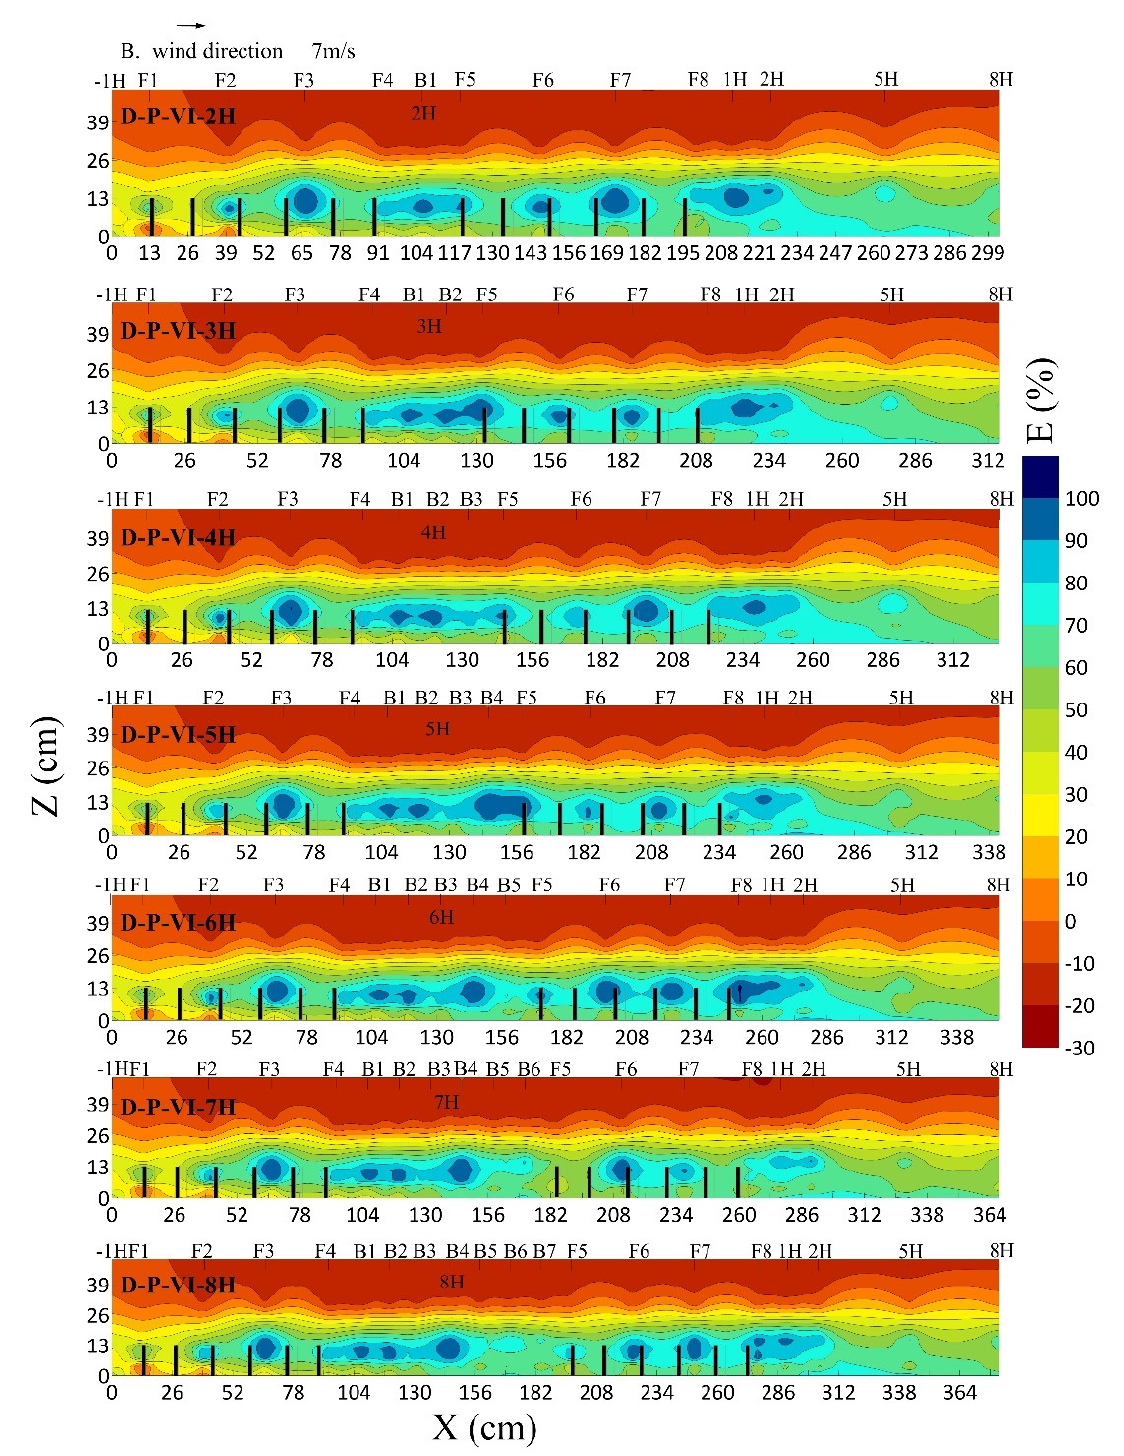
Figure 8. Contour map of the distribution of the shelter efficiency of double pure arbor shelterbelts under different belt spacings. The belt spacing ranges from 2H to 8H. The abscissa represents the downwind distance (cm) and the ordinate represents the vertical height (cm). The top abscissa represents the observation point. 7 m · s − 1 . The legend indicates the shelter efficiency.